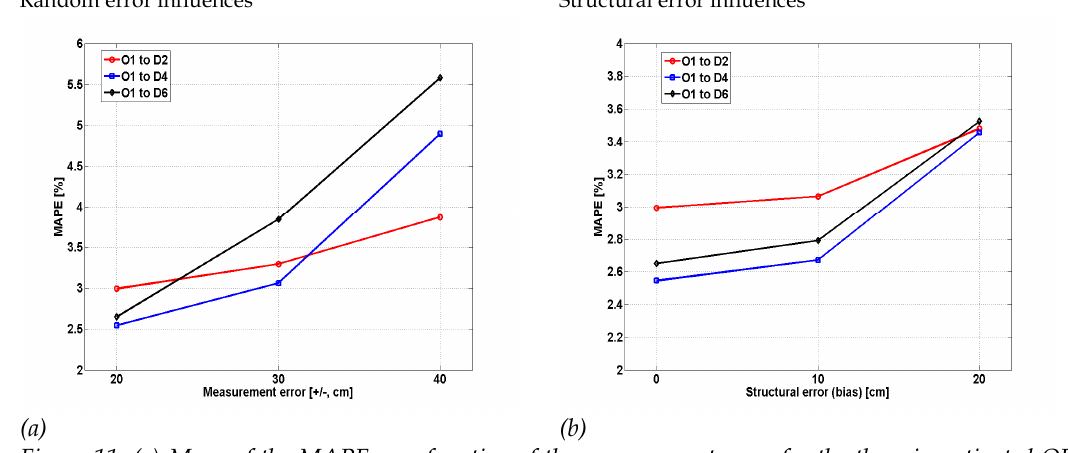
Figure 11. (a) Mean of the MAPE as a function of the measurement error for the three investigated OD- combinations, (b) Mean of the MAPE as a function of the structural error for the three investigated OD-